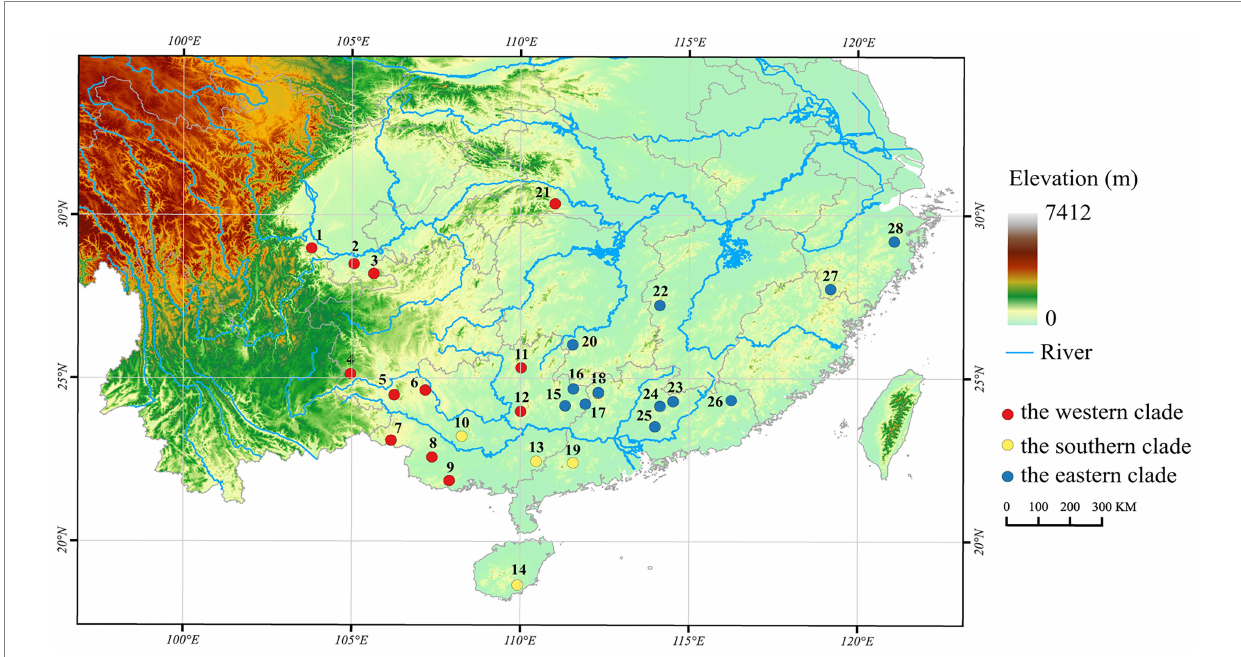
FIGURE 1 Locations of 28 populations of Odorrana graminea sensu stricto (Red circle: the western clade; Yellow circle: the southern clade; and Blue circle: the eastern clade. The numbers in this figure correspond to those given in Table